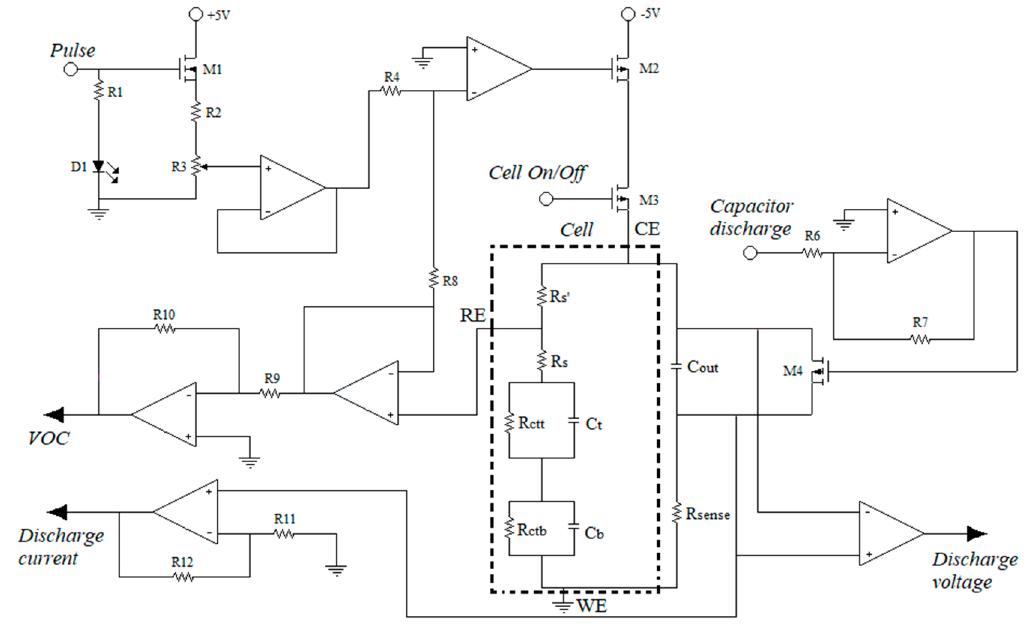
Figure 4. Schematic block electronic architecture of the DNA biosensor.